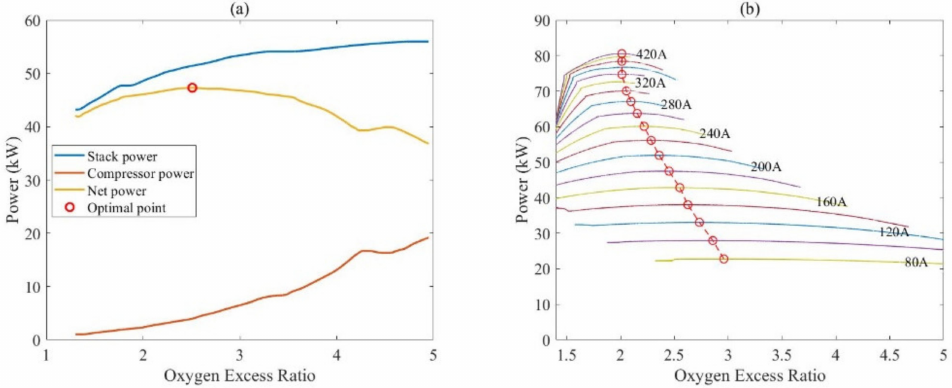
Figure 3. Optimal oxygen excess ratio parameters of the PEMFC system: ( a ) 180 A; ( b ) 180~240